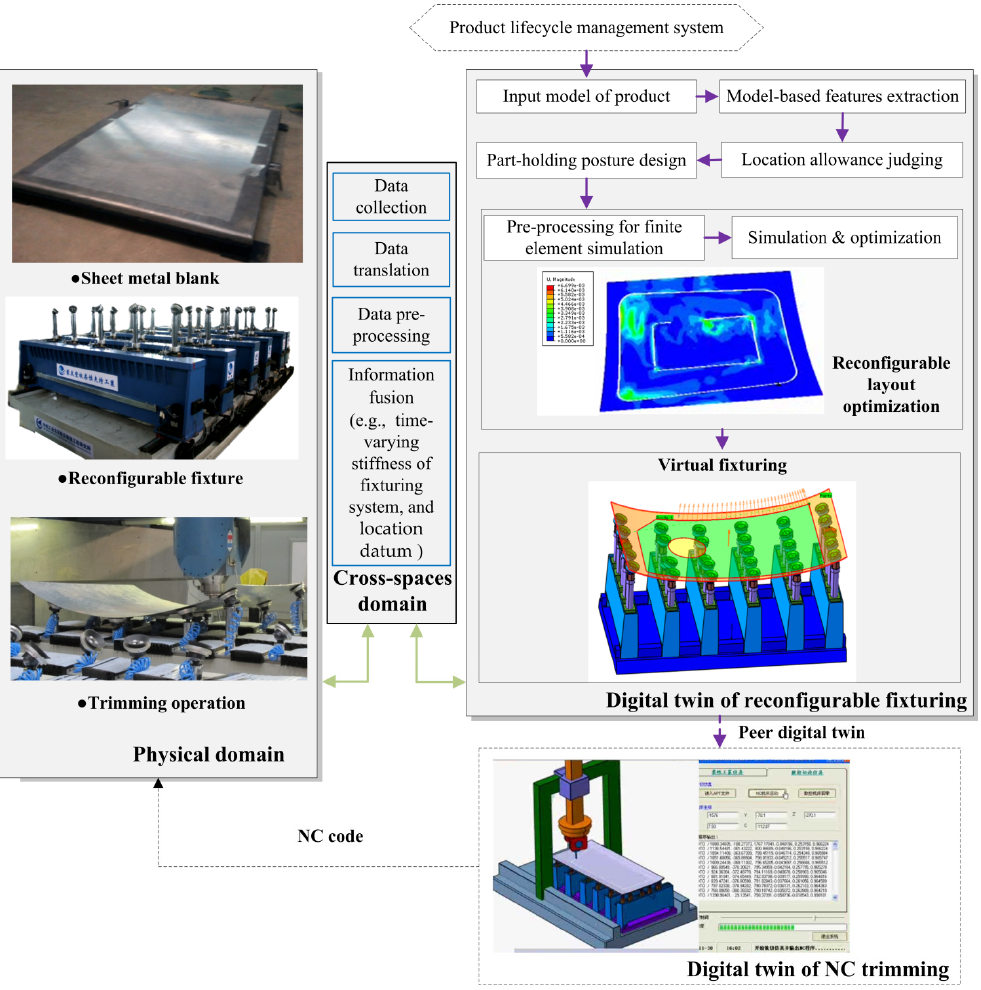
Figure 2. Digital twin-based reconfigurable fixturing for trimming operation of aircraft skins.